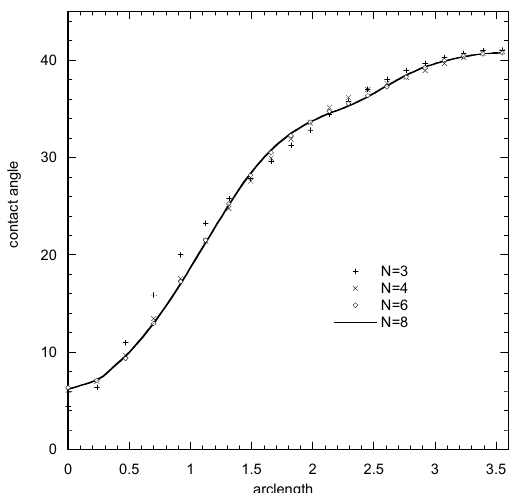
Figure 4. Convergence of the contact angle (degrees) distribution along the contact line (composite circular–elliptical shape) for increasing number N (accounting for number of terms in boundary collocation expansion).